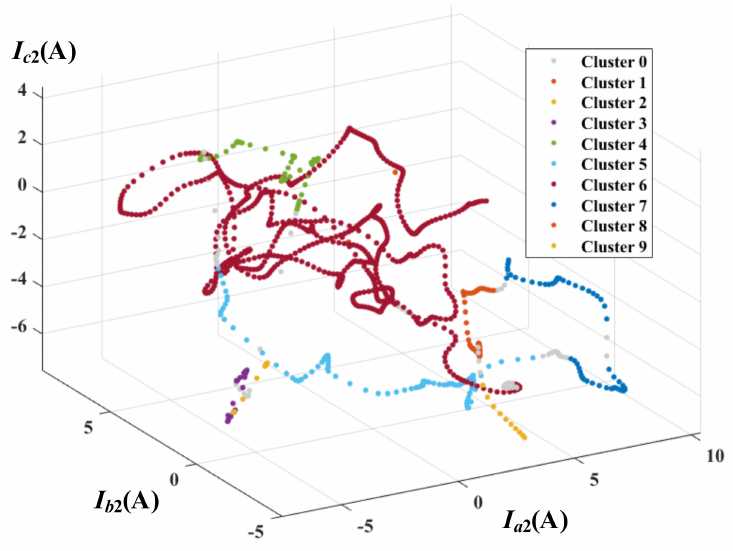
Figure 7. The cluster scatter scheme of sheath currents I a 2 , I b 2 and I c 2